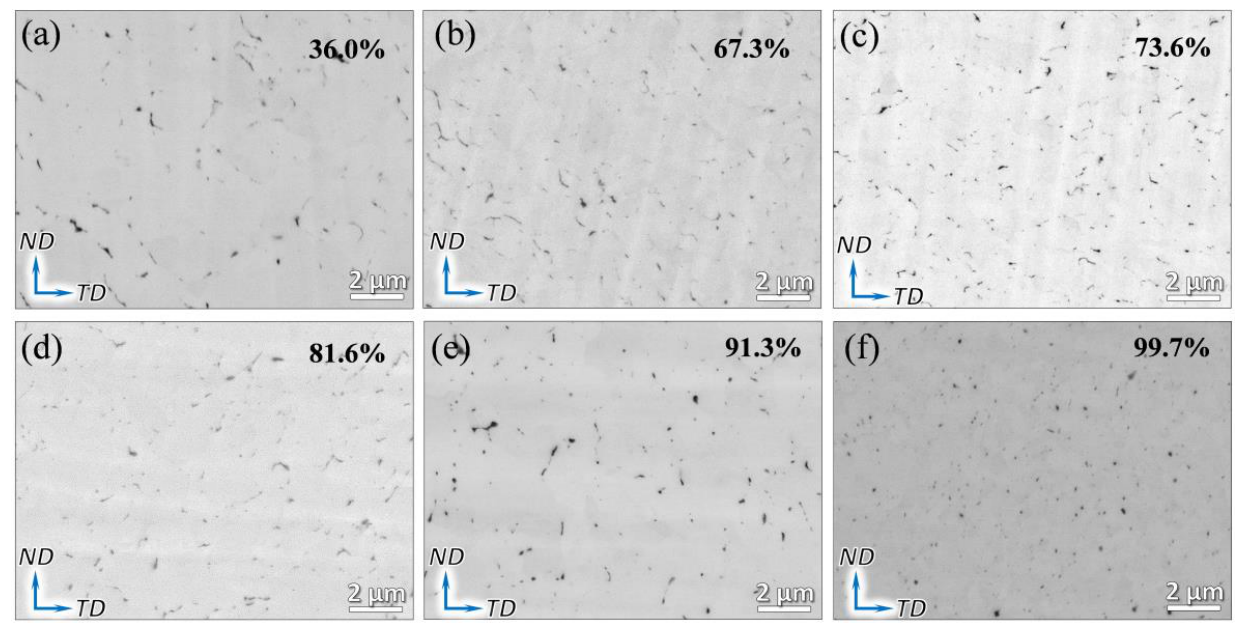
Figure 5. SEM-BSE images of the as-drawn composite with different drawing reductions. ( a ) 36.0%, ( b ) 67.3%, ( c ) 73.6%, ( d ) 81.6%, ( e ) 91.3%, and ( f ) 99.7%.